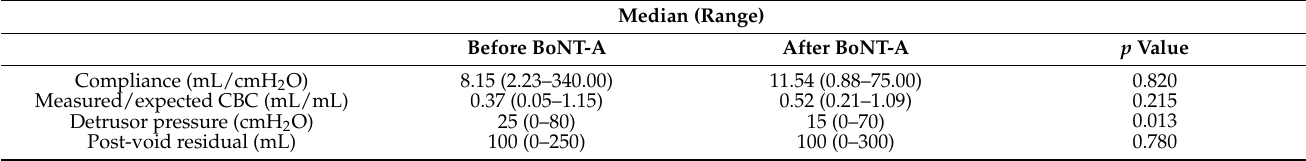
Table 1. Change in urodynamic parameters from before to after BoNT-A injection (n = 15). Median (Range) Before BoNT-A After BoNT-A p Value